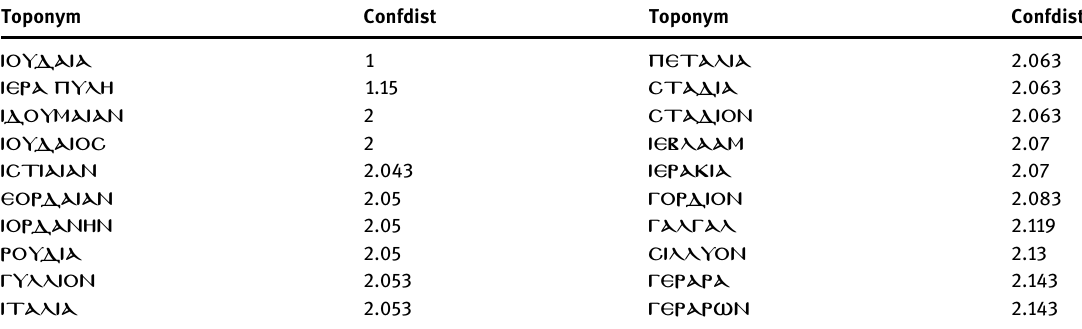
Table 2: The 20 closest alternatives to IO ϒΔ AIAN based on palaeographical confusion of characters Toponym